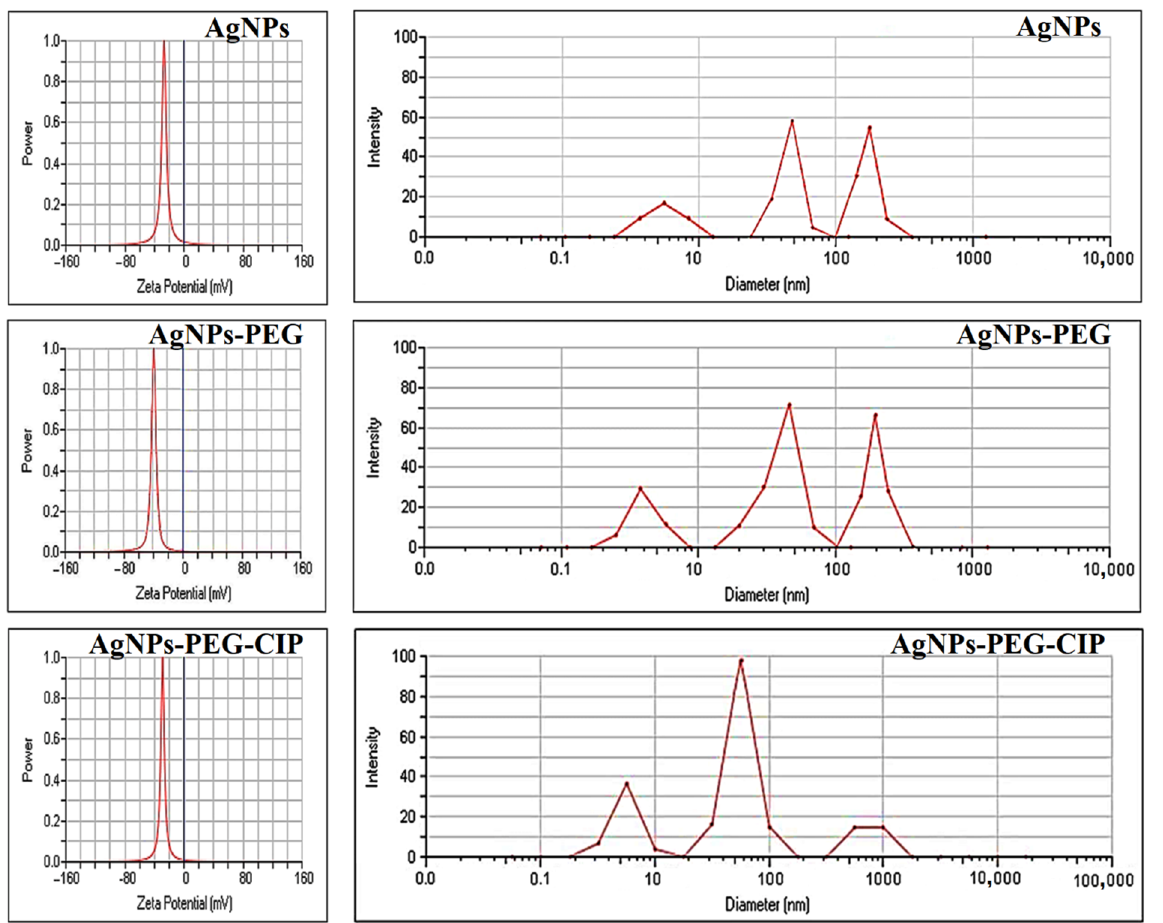
Figure 8. Zeta potentials and dynamic light scattering analyses of AgNPs, AgNPs-PEG, and AgNPs- PEG-CIP.